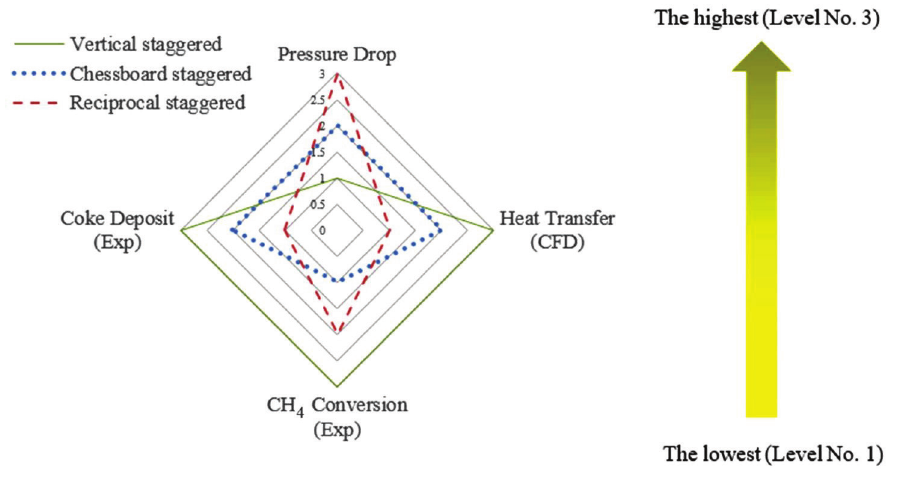
Fig. 11 – Radar chart for the effects of packing pattern on pressure drop, heat transfer, CH conversion, and coke